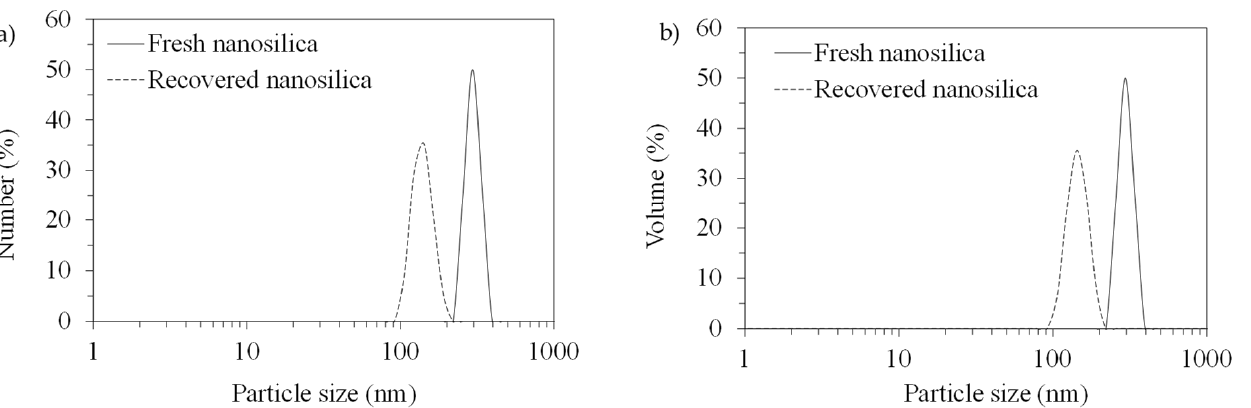
Figure 8. DLS analysis of fresh ( a ) and recovered nanosilica ( b ).